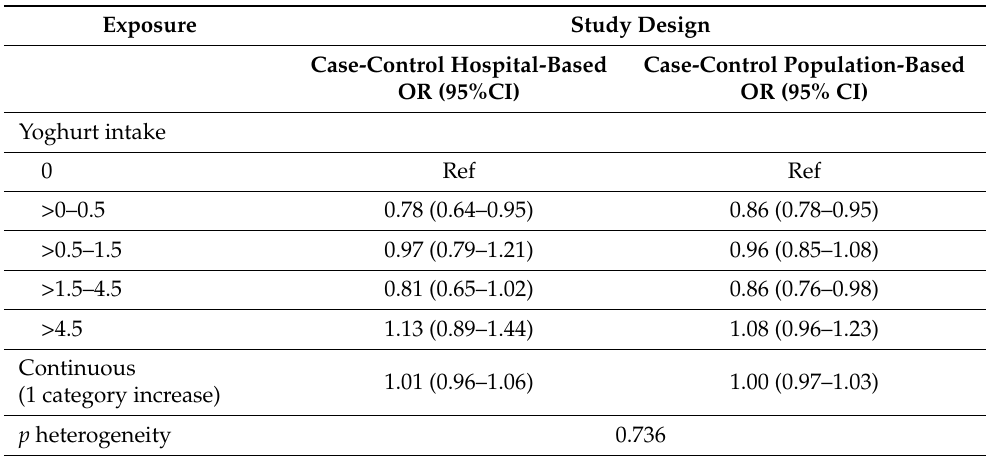
Table 4. Odds ratios (OR) and 95% confidence intervals (CI) of the association of yoghurt intake by approximate portions of yoghurt intake and study